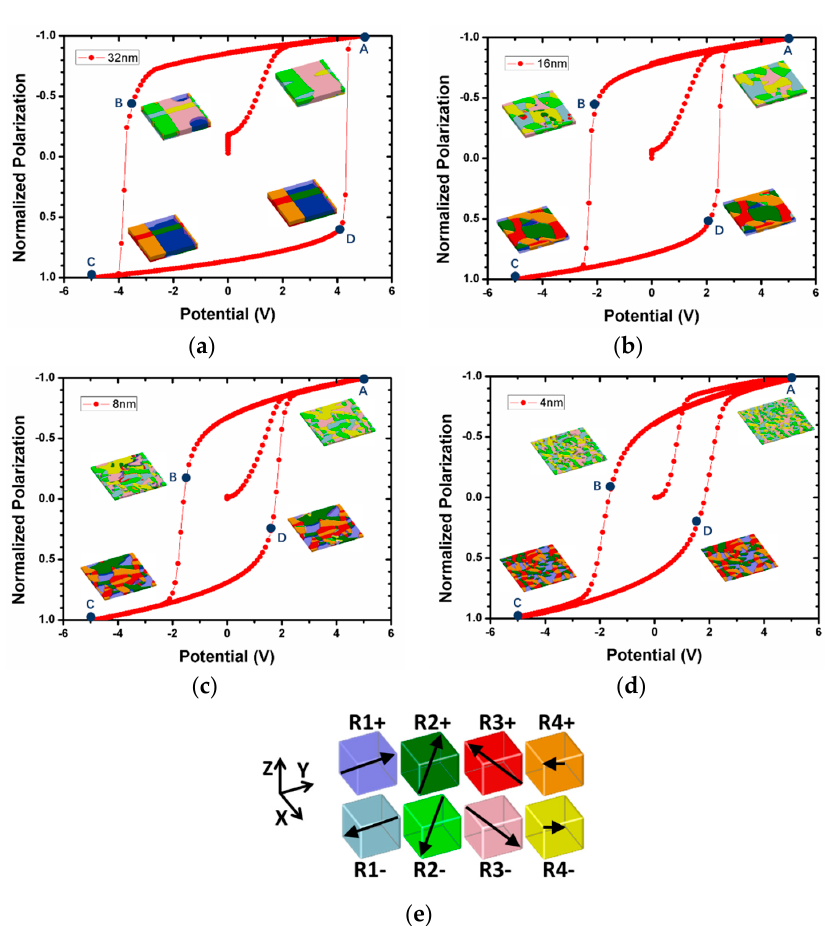
Figure 4. Hysteresis loops ( P-E loops) for thin films with different film thicknesses: ( a ) 32 nm, ( b ) 16 nm, ( c ) 8 nm, and ( d ) 4 nm. Domain patterns for specific points are provided alongside the P-E loop. ( e ) Representative colors for eight rhombohedral variants in domain patterns.